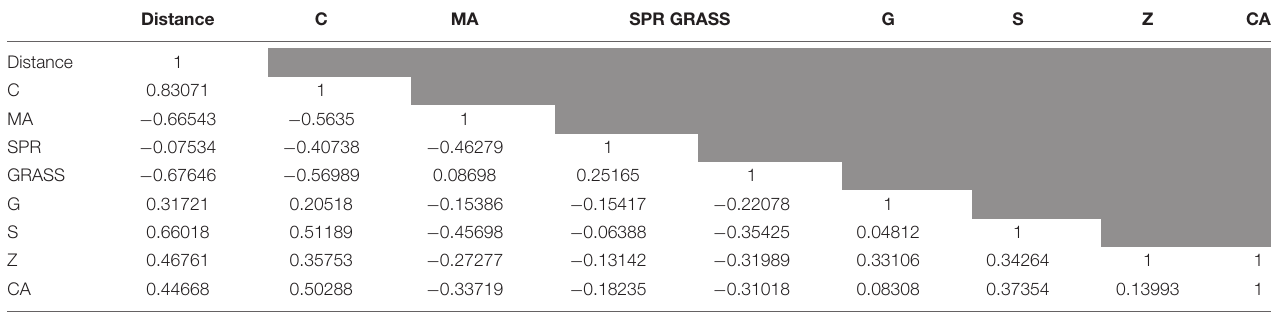
TABLE 2 | Pearson’s correlation coefficients for major benthic categories in regards to distance to the river outlet. Distance C MA SPR GRASS G S Z